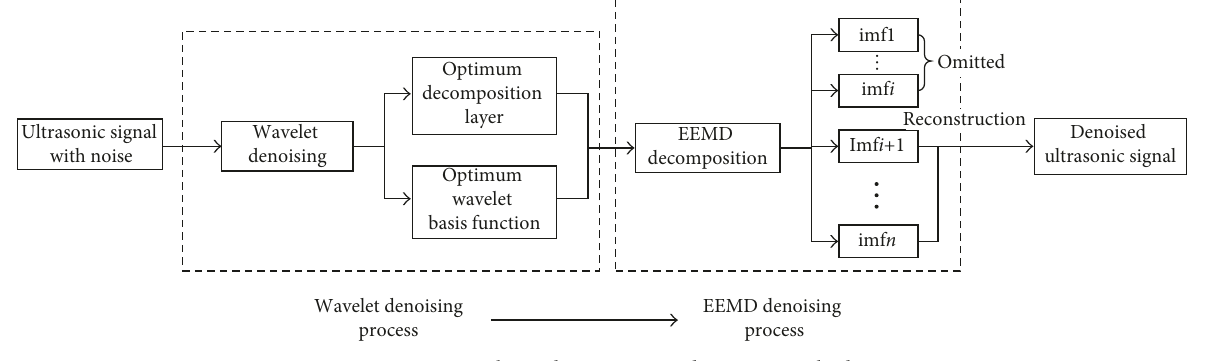
Figure 1: Wavelet and EEMD joint denoising